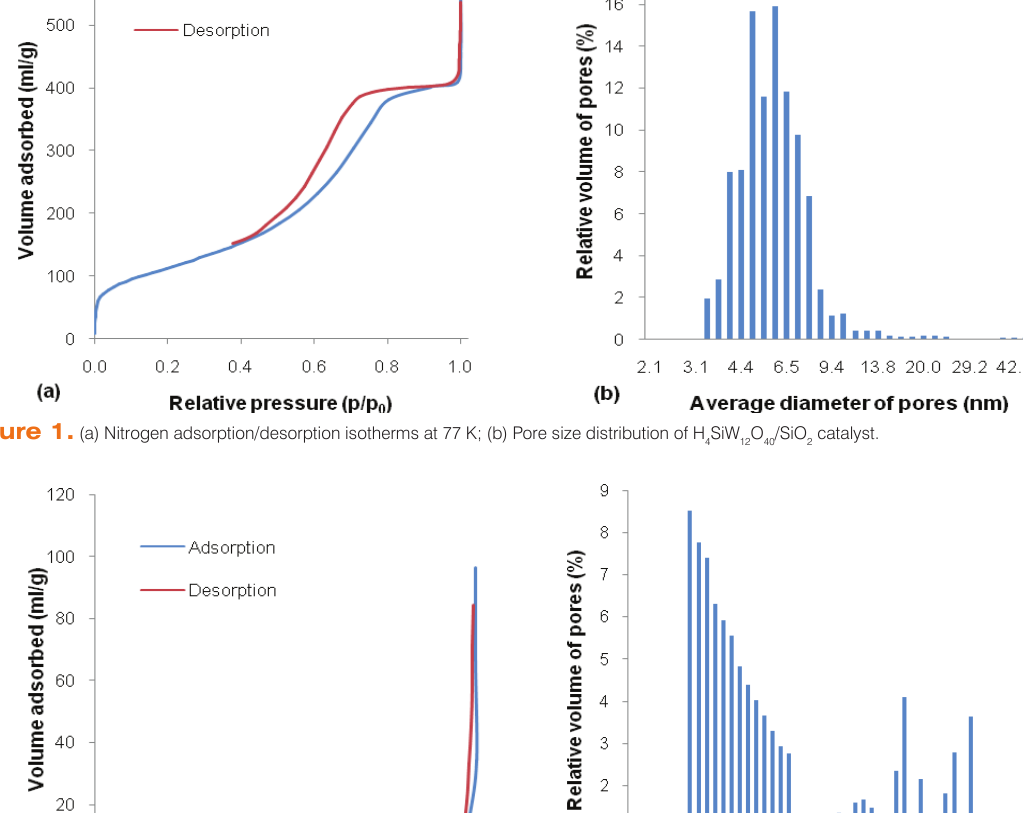
SiW O /TiO catalyst. 4 12 40 2